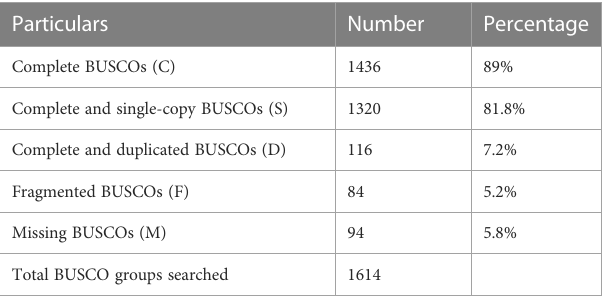
TABLE 2 Summary of BUSCO